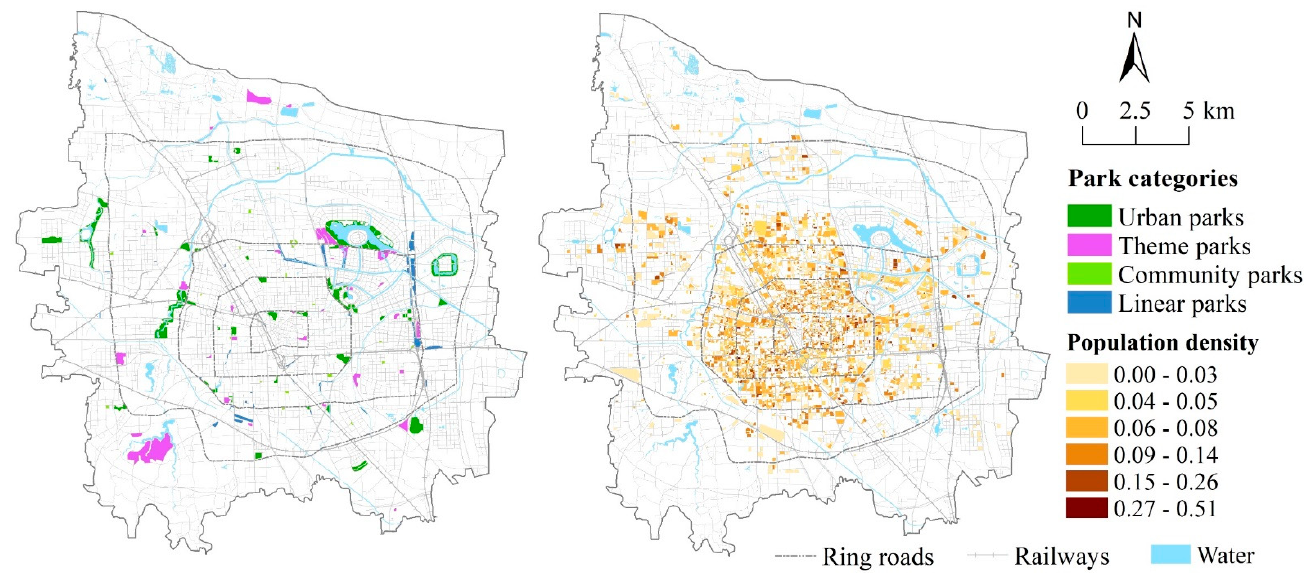
Figure 3. Spatial distribution of parks and population density in the central urban area of Zhengzhou.